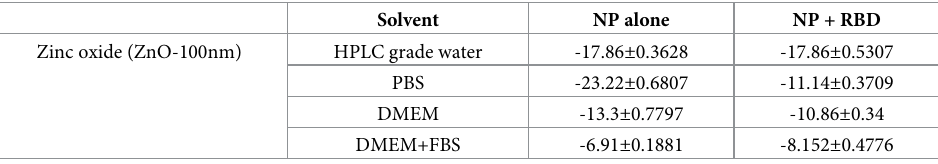
Table 1. Zeta potential measurements of ZnO NP-100 nm in response to RBD